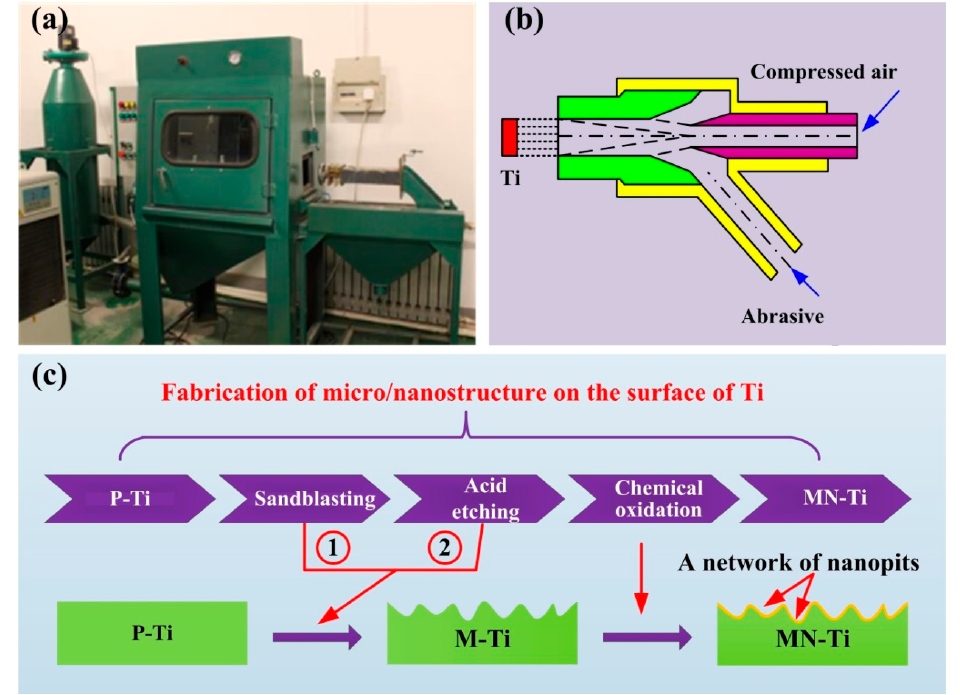
Figure 1. The equipment ( a ) and schematic diagrams ( b ) of the sandblasting process, and the process of fabrication of micro/nanostructure on the surface of Ti ( c ).